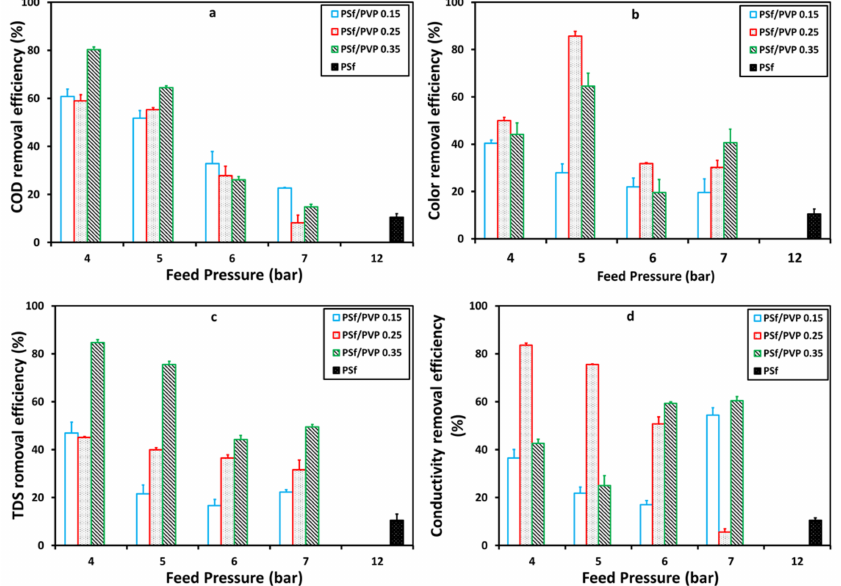
Figure 9. The membrane removal efficiency profile of chemical oxygen demand (COD) ( a ), color ( b ), total dissolved solid (TDS) ( c ), and conductivity ( d ) with feed pressure on the membrane filtra- tion process.